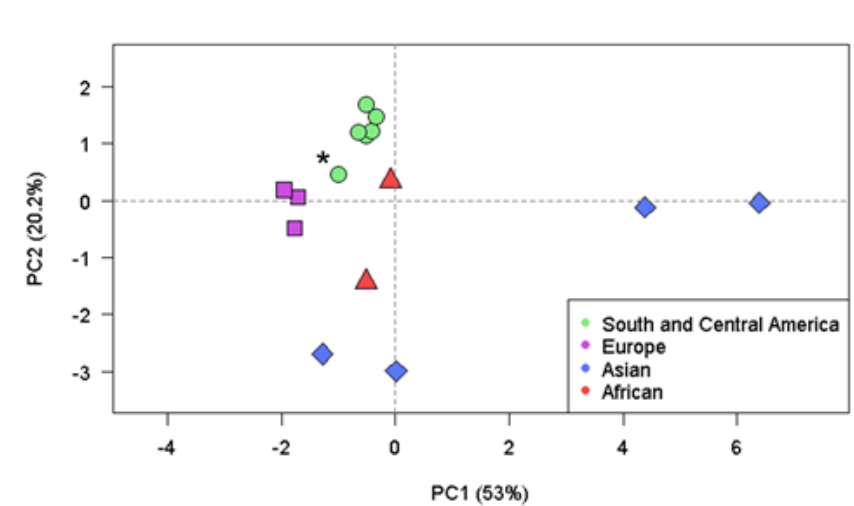
Figure 2. Comparison of HLA allele frequencies in different world populations, including the Chilean population from Talca. ( A ) Hierarchical population clustering; ( B ) Principal component analysis. * The studied population.